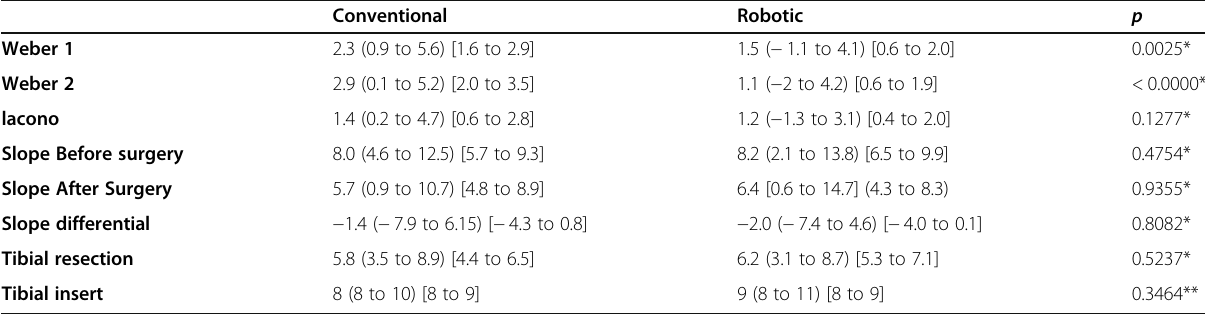
Table 3 Radiological measurements were compared between groups, and a significant difference was found in both Weber methods. The range is summarized between round brackets and the interquartile range between square